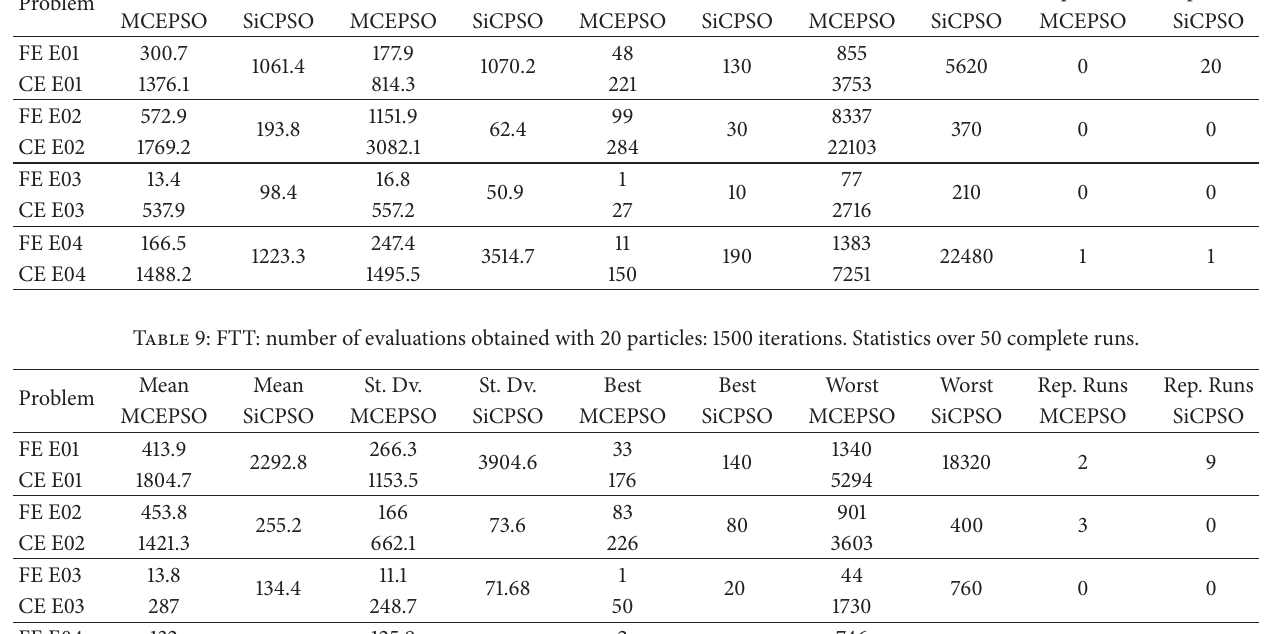
Table 8: FTT: number of evaluations obtained with 10 particles: 3000 iterations. Statistics over 50 complete runs. Problem